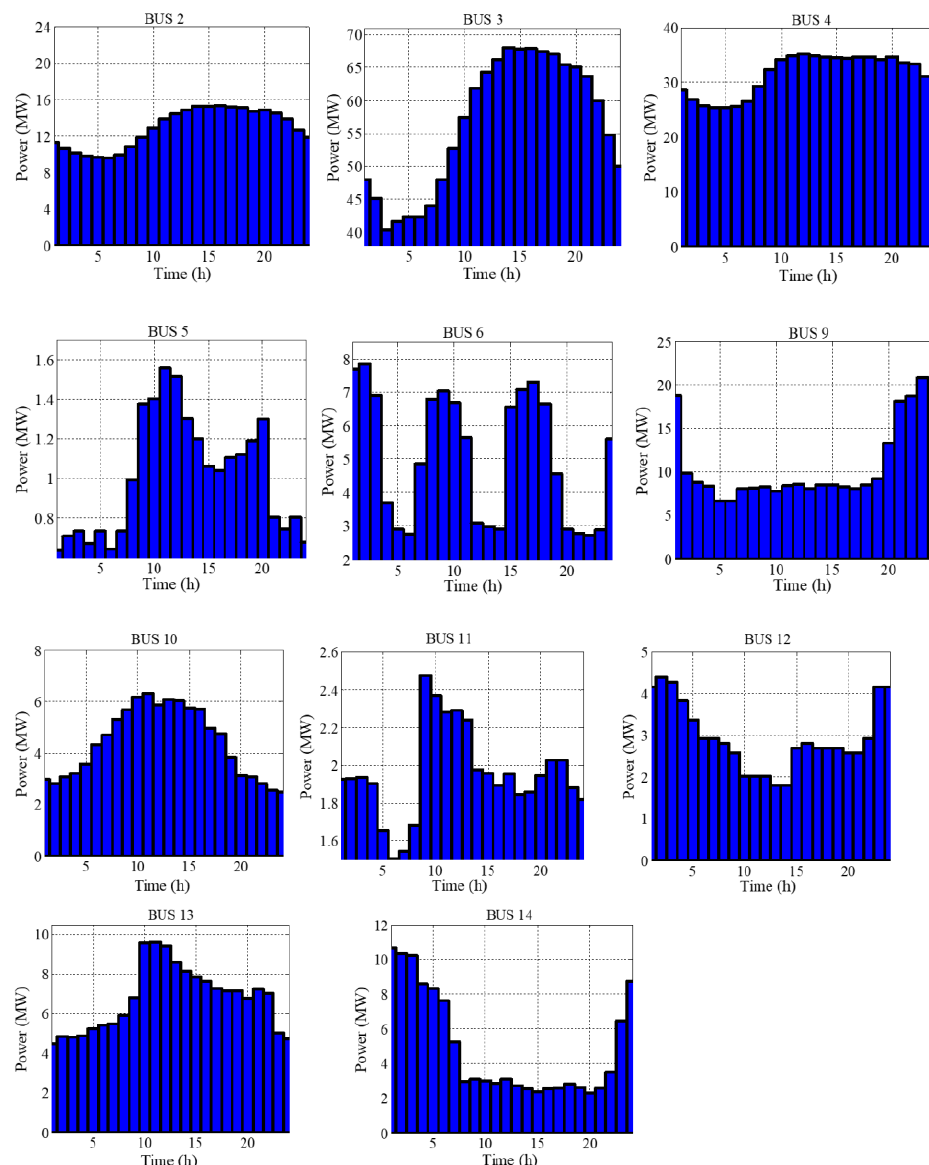
Figure 1. VPP system comprised of IEEE 14-bus test system and five microgrids.